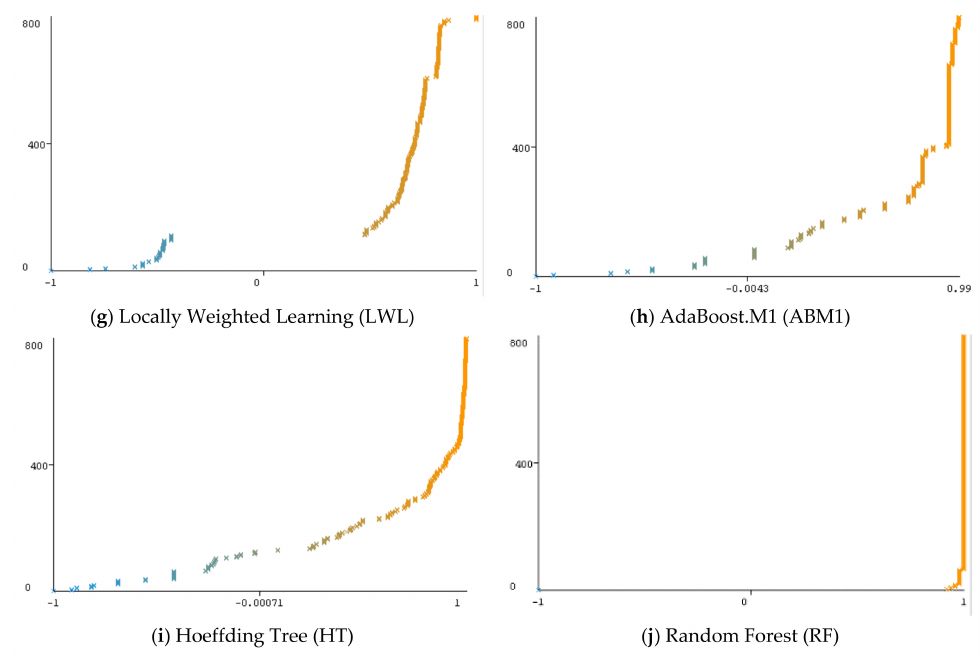
Figure 4. Margin curves for NBC, BNC, DT, LR, NN, SVM, LWL, ABM1, HT, and RF